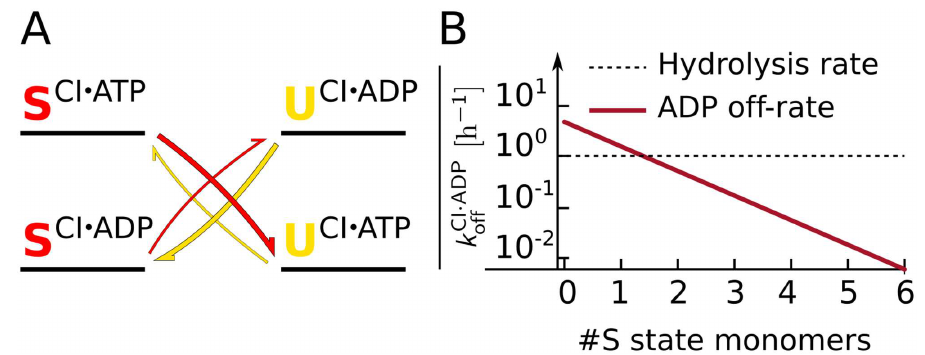
Fig 4. The phosphorylation state of the CII domain regulates the ADP fraction in the CI domain by changing the ADP releaserate, but not its affinity. (A) Cartoonthat illustrates why the experiments rule out the latter “affinity” scenario.The cartoon shows a free-energy landscapefor this affinity scenarioin which the phosphorylation state of CII determinesthe affinity of ADP for CI; specifically, the cartoon illustrates the case where a monomerin the S state stabilizesADP in the bindingpocket of the CI domain.The superscripts denotethe state of the CI bindingpocket. The S-phosphorylated state lowers the free energyof the CI (cid:1) ADP state comparedto the U state, thereby decreasing the ADP-off rate in the CI bindingpocket. It follows from detailedbalancethat when the CI domain has ADP bound,the phosphotransfer from S to U is uphillin free energy, which decreasesthe phosphotransfer rate. The diagonal arrows give the phosphotransfer reactions from U to S (yellow)and S to U (red). When the CI domainis predominantly in the ATP state, as was done in [27] by loweringthe hydrolysisrate with a mutation, the affinity scenario,as illustratedin the cartoon, would predict that the dephosphorylationrate from S to U increases.However, the experiments show no significant changein phosphotransfer rates, making this affinity scenariounlikely.Based on these arguments, we predict that phoshorylationof CII does not changethe affinity, but does changethe absolutesrates of ADP dissociationand association.(B) ADP dissociationrate as a function of the number of S state monomers in the hexamer, assuming the other monomers are in the U state. Between 1 and 2 monomers in the S state, the dissociationrate is higherthan the hydrolysisrate which puts the bindingpockets of CI domainpredominantly in the ATP state, driving the hexamer to the active conformational state.